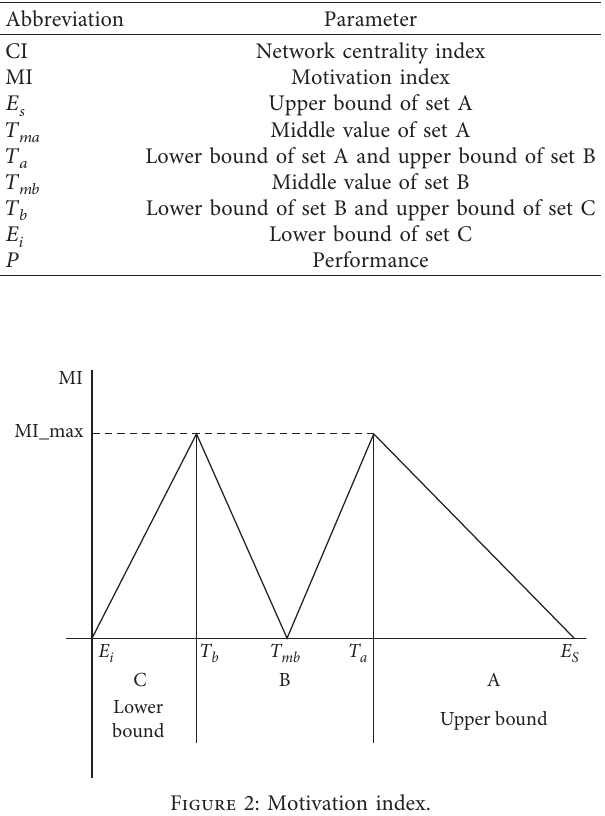
Table 1: Description of the simulation model’s parameters.